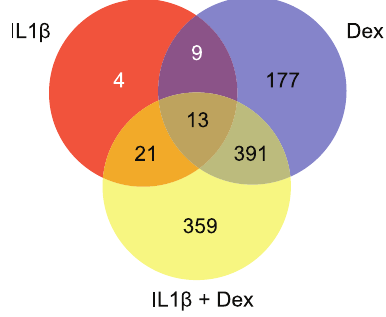
Gene Expression Analysis